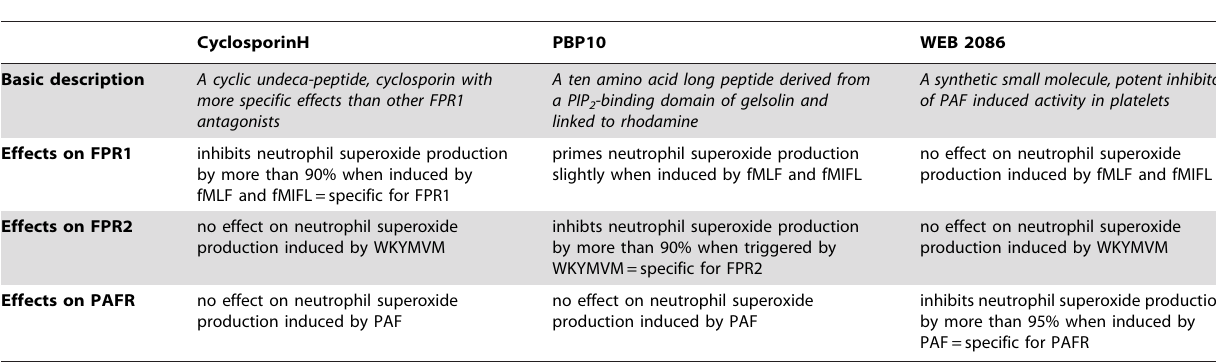
Table 1. Characteristics of the receptor antagonists